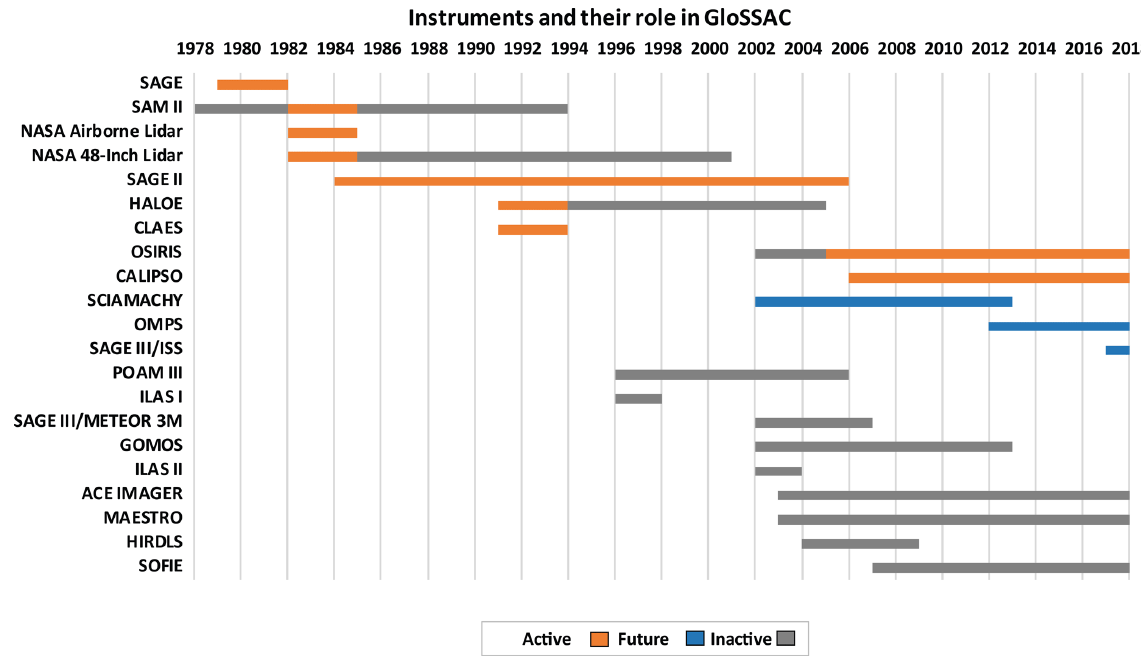
Figure 1. Space-based sources for stratospheric aerosol extinction coefficient data and their status in GloSSAC. Two non-space instruments whose data are used in GloSSAC (NASA Airborne Lidar and NASA 48-inch lidar) are also